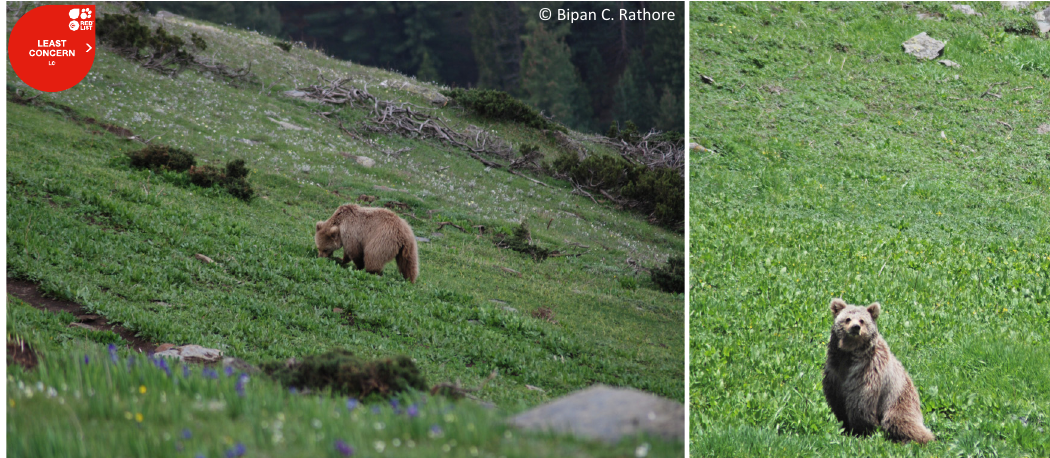
Image 3. Himalayan Brown Bear foraging on Rumex nepalensis in Kugti Wildlife Sanctuary.